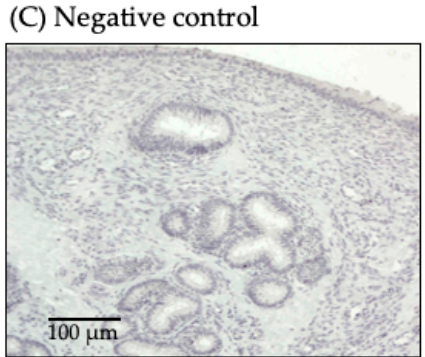
Figure 2. ( A ) Immunohistochemical localization of fibroblast growth factor 1 (FGF1) protein (brown), ( B ) the localization of FGF2 protein, and ( C ) the negative control. Positive staining for FGF1 and FGF2 in the endometrium of Simmental heifers was observed in luminal ( a ) and glandular ( b ) epithelium, in the stromal endometrium ( c ) and in blood vessels ( d ).